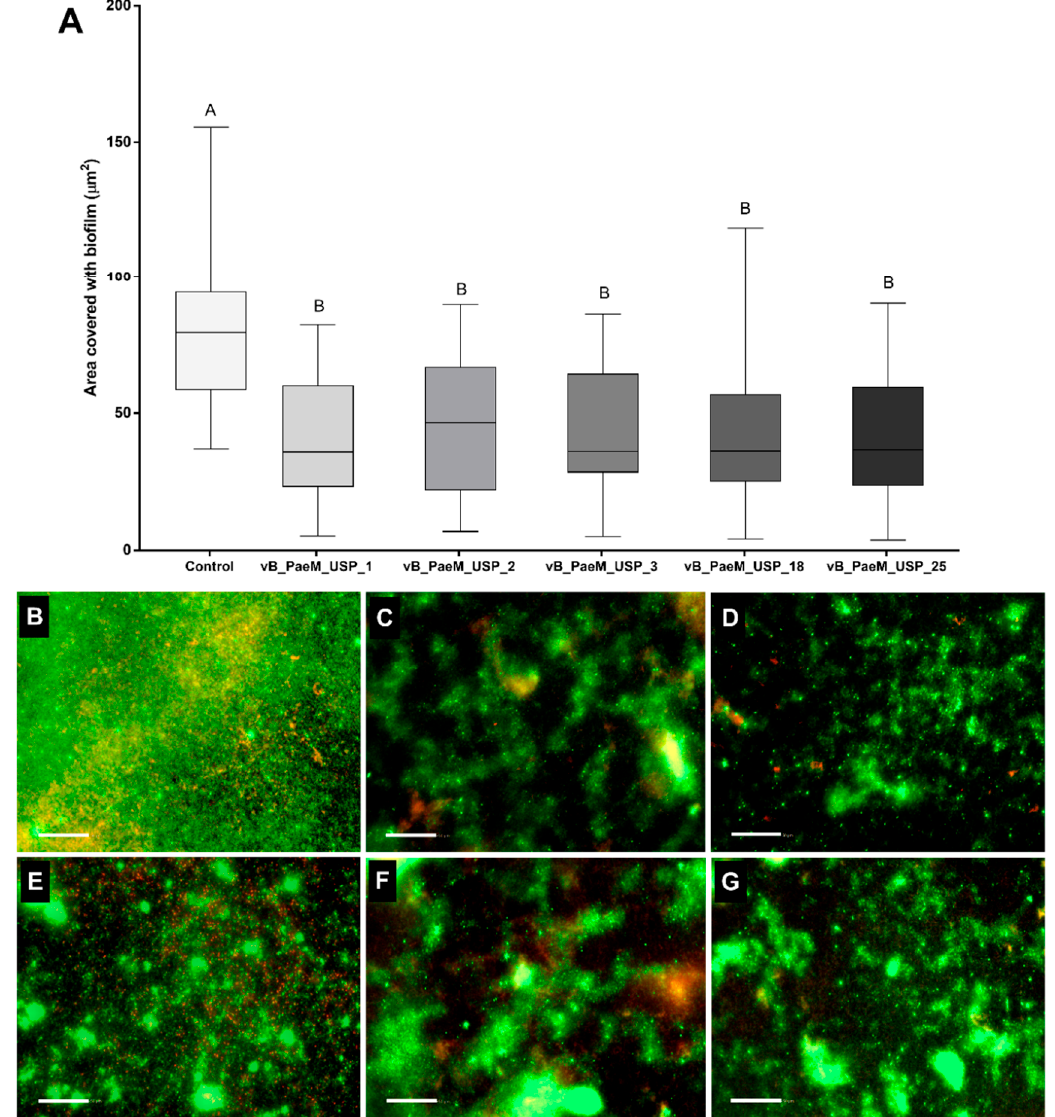
Figure 1. ( A ) Biofilm-covered areas, expressed in µm 2 , after phage treatment. Comparisons were conducted among groups by means of multiple comparisons considering strains and bacteriophages in a generalized linear model with Bonferroni correction. AB Different capital letters indicate statistically significant differences ( p < 0.05). ( B – G ) Representative fluorescent images of P. aeruginosa illustrate the control group ( B ) and the action of phages vB_PaeM_USP_1 ( C ), vB_PaeM_USP_2 ( D ), vB_PaeM_USP_3 ( E ), vB_PaeM_USP_18 ( F ), and vB_PaeM_USP_25 ( G ). Scale bar = 50 µm.